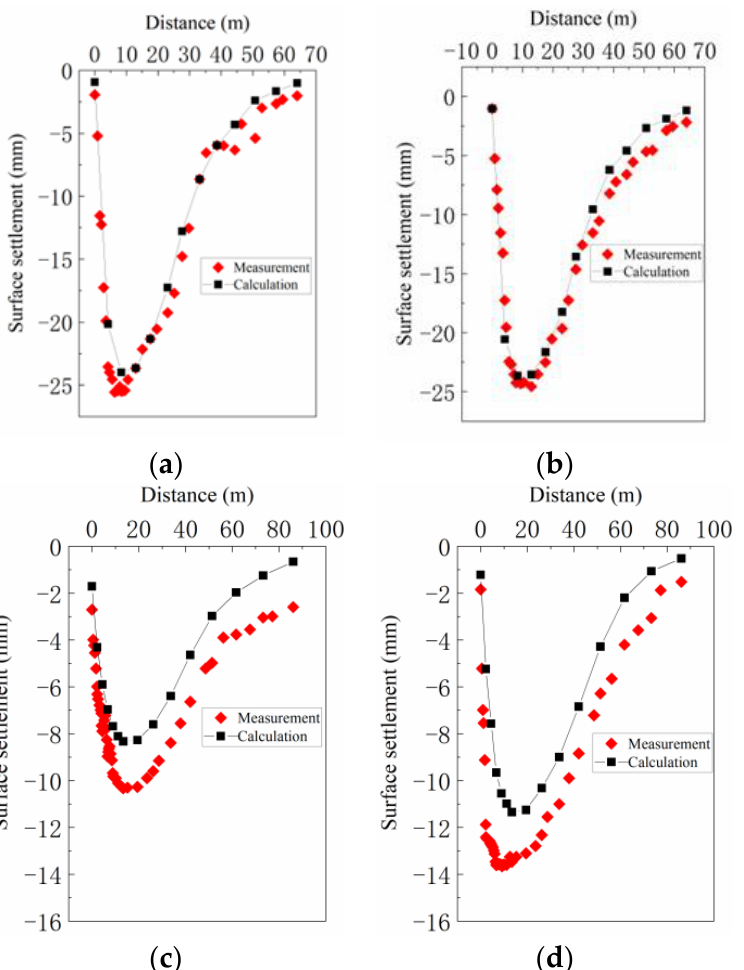
Figure 12. Monitoring and simulating settlement curve of soil around excavation. ( a ) Point A1; ( b ) Point B1; ( c ) Point C1; ( d ) Point D1. ( b ) Point B1; ( c ) Point C1; ( d ) Point